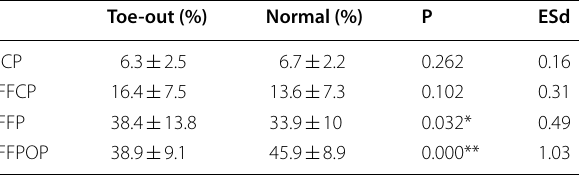
Values are expressed as mean